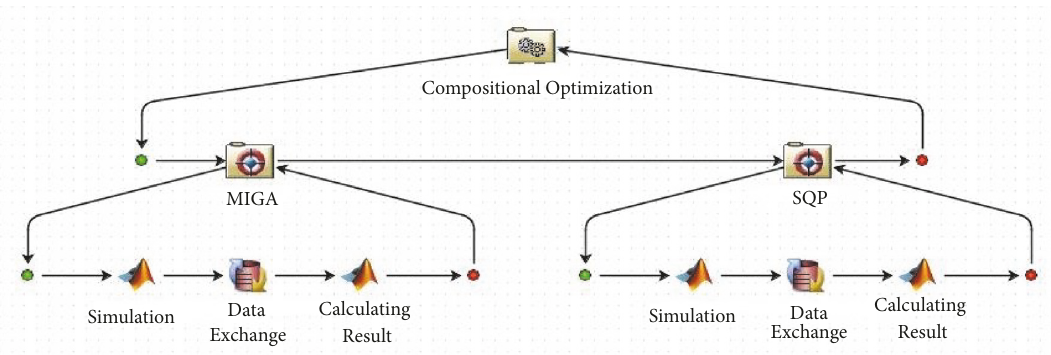
Figure 12: Isight automatic optimization platform.